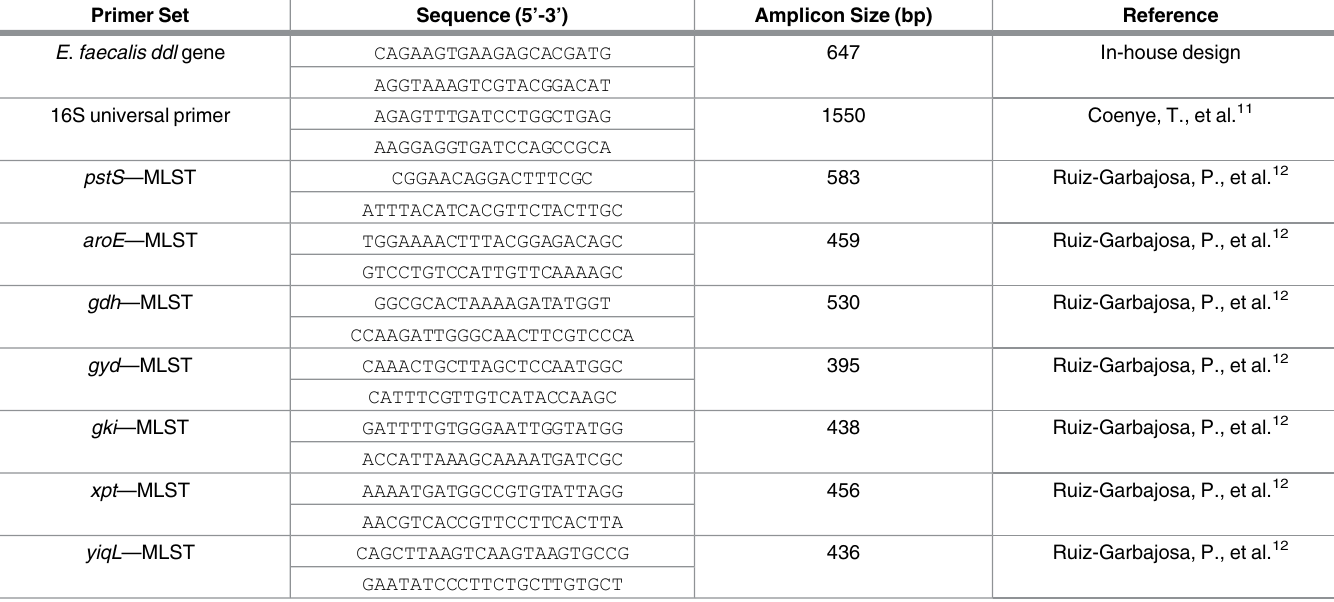
Table 2. Primers Used for the Identification and Characterization of E . faecalis